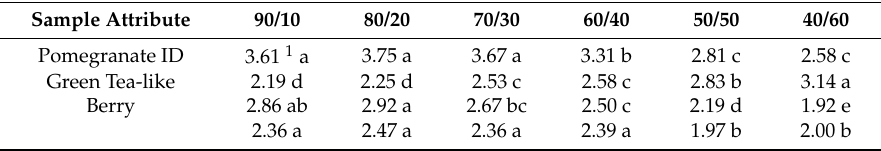
Table 2. Mean intensity scores for PG–GT samples attributes. Means with different letters were significantly different ( p < 0.05) using Fisher’s LSD